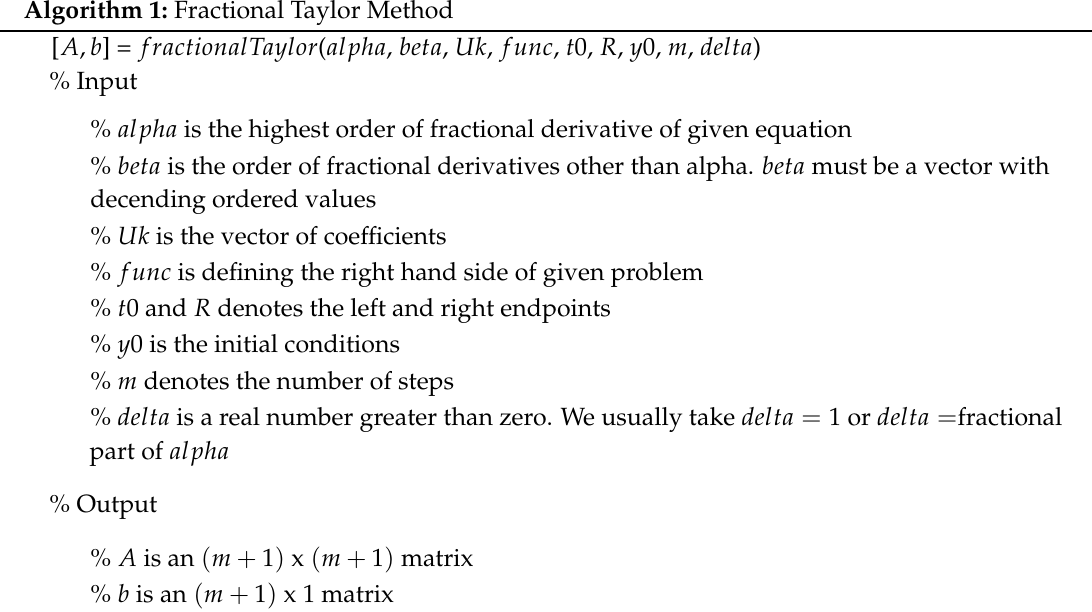
Algorithm 1: Fractional Taylor